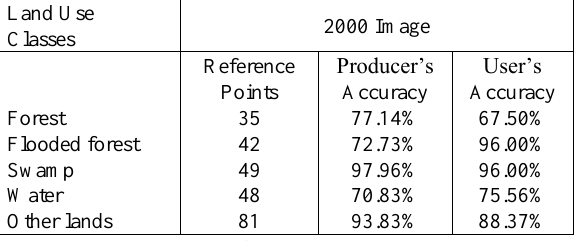
Table 3. The results of accuracy assessment based on